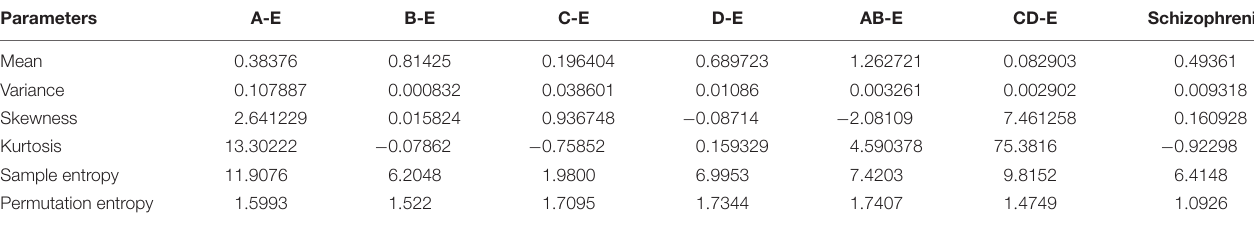
TABLE 1 | Analysis of statistical parameters for Fusion Hybrid Model (FHM) in various biosignal datasets.